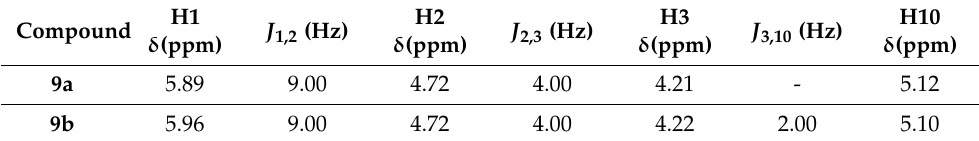
Table 2. Chemical shifts and coupling constants for protons of new formed pyrrole ring in compounds 9a , b. H1 Compound δ (ppm)